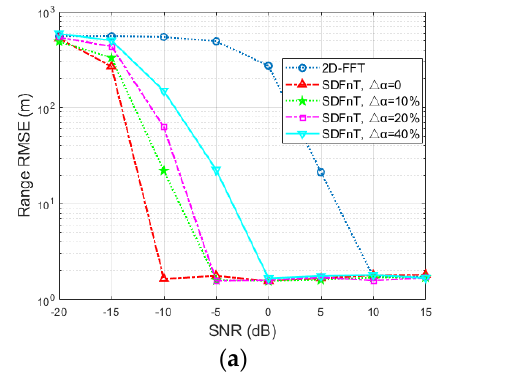
Figure 5. Single-target results in terms of SNR ( a ) RMSE for the range estimation ( b ) RMSE for the velocity estimation.